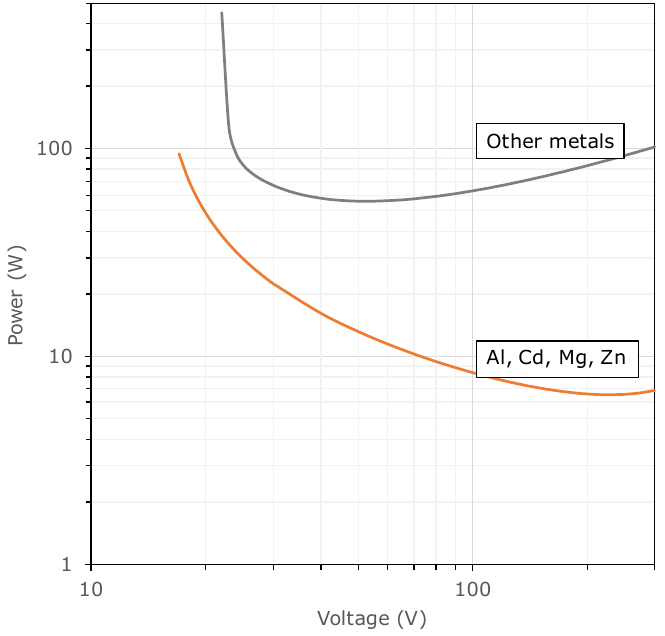
Figure 9. Minimum power needed for ignition of methane atmospheres, derived from the SMRE V–I data .